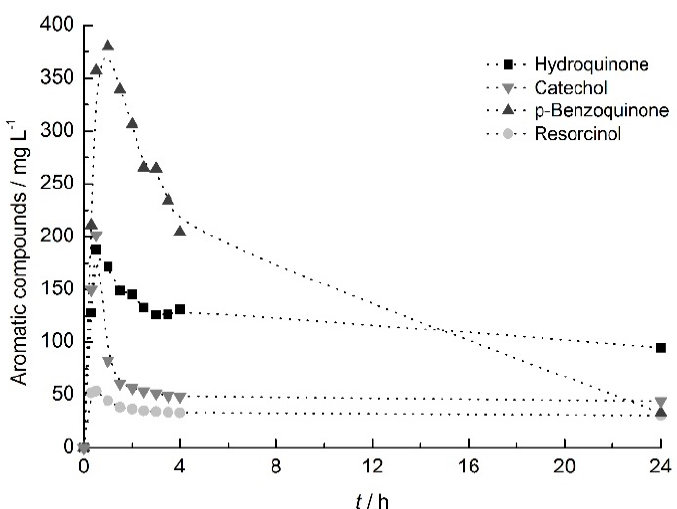
Figure 6. Evolution of aromatic intermediates of phenol oxidation when using ROXN 673 in the CWPO process developed under the conditions given in Figure 2.